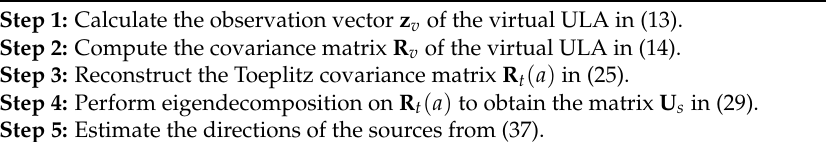
Table 1. The proposed coprime array DOA estimation